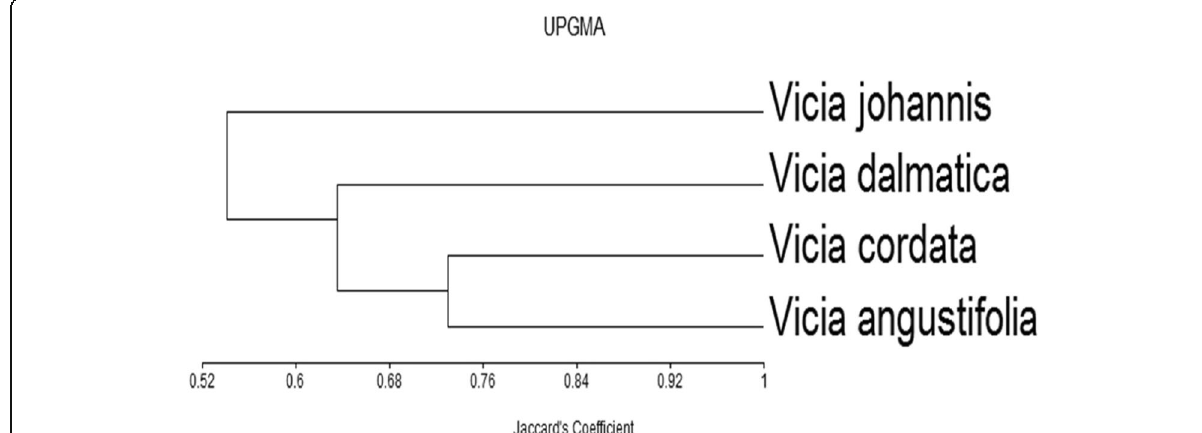
Fig. 3 Dendrogram illustrating the relationships of the four Vicia species based on seed storage proteins, and as constructed by unweighted pair group arithmetic (UPGMA) and similarity matrices computed according to Jaccard ʼ s